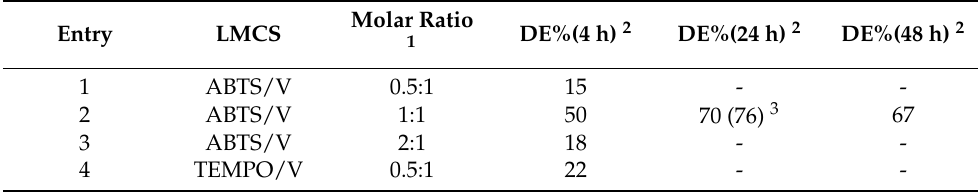
Table 2. Eumelanin decolorization with LMCS in different molar concentration ratios and at different reaction times (4 h, 24 h, and 48